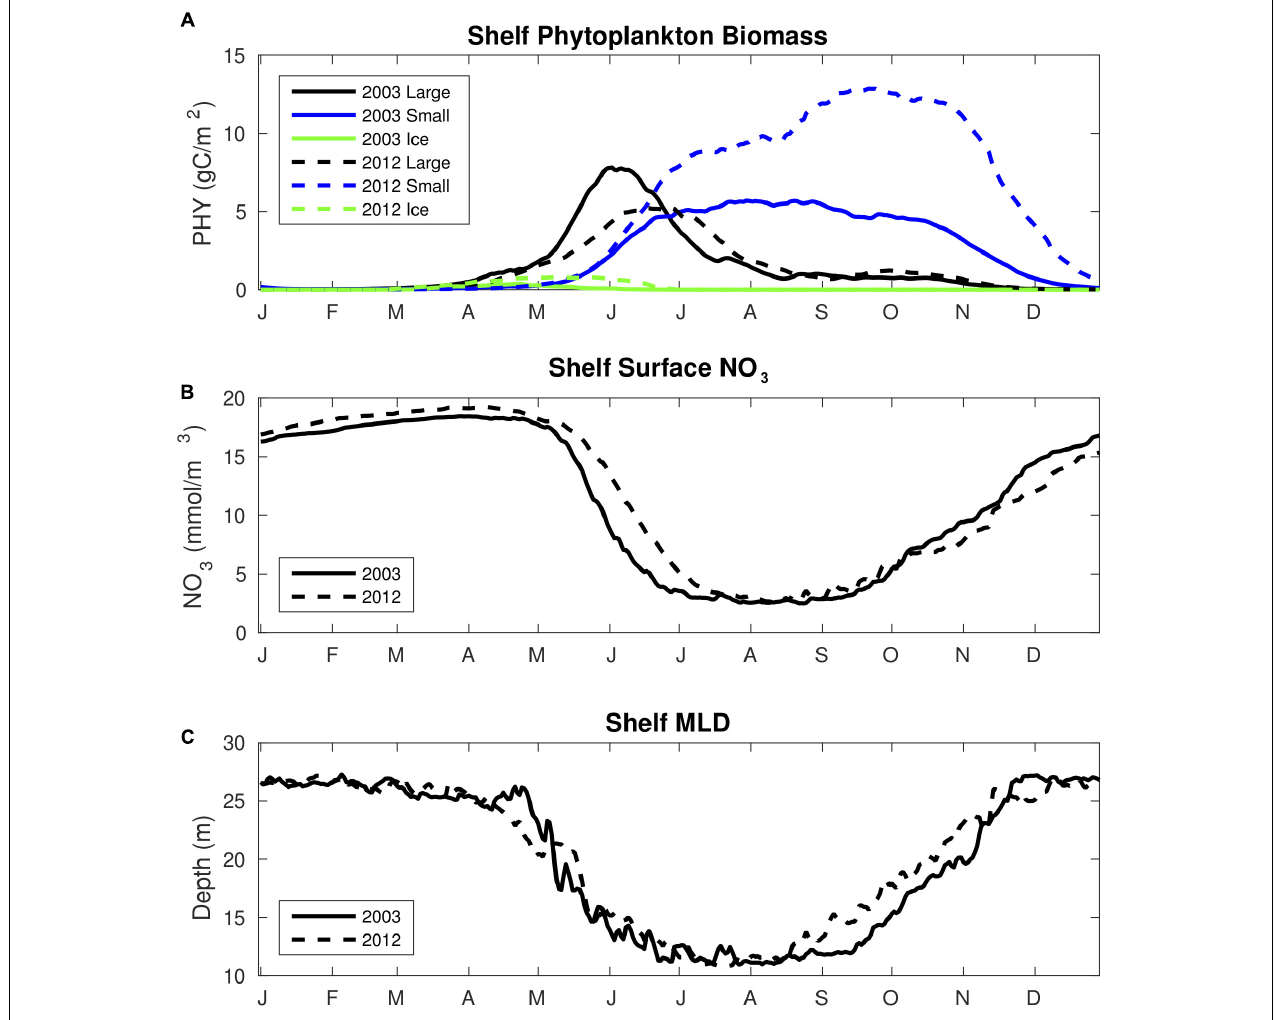
FIGURE 13 | Time series plots of area-weighted spatial mean (A) 30 m column integrated phytoplankton biomass, (B) surface NO 3 − , and (C) mixed layer depth for model year 2003 and 2012. Phytoplankton biomass is divided into the large phytoplankton (black line), small phytoplankton (blue line), and ice algae (green line) functional